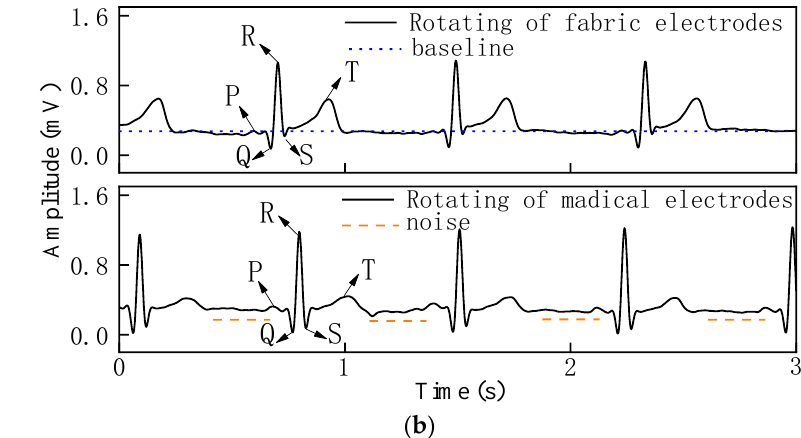
electrodes and standard medical electrodes in swinging state.